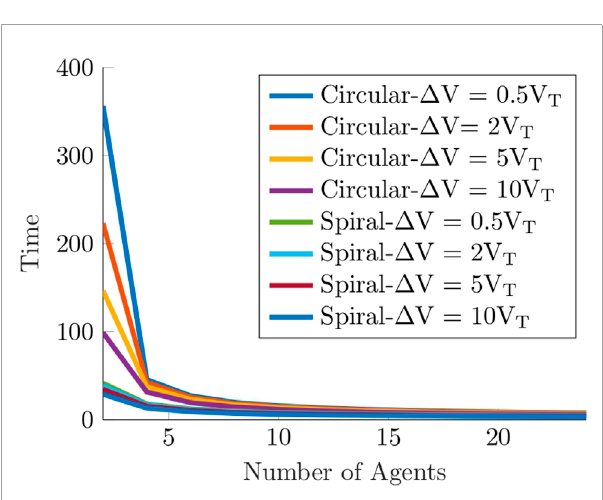
FIGURE 4 Total search times until complete cleaning of the evader region for the circular and spiral sweep processes. We simulated sweep processes with an even number of agents, ranging from 2 to 24 agents, that employ the multi-agent circular and spiral sweep processes. We show results obtained for different values of speeds above the circular critical speed of 2 sweepers. The chosen values of the parameters are r = 10, V T = 1 and R 0 =